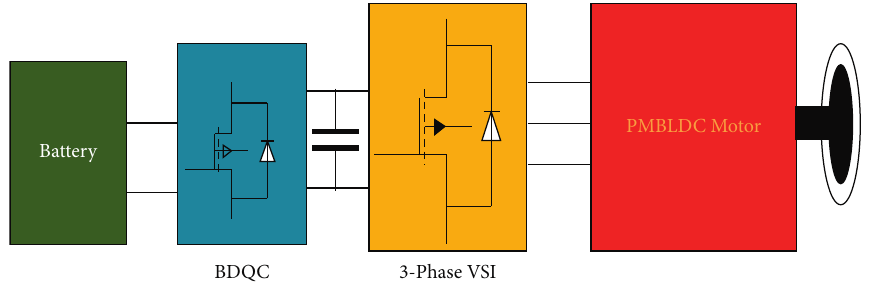
Figure 1: Schematic of the electrical system of the powertrain in EVs. Table 1: Comparison of different bidirectional converters.